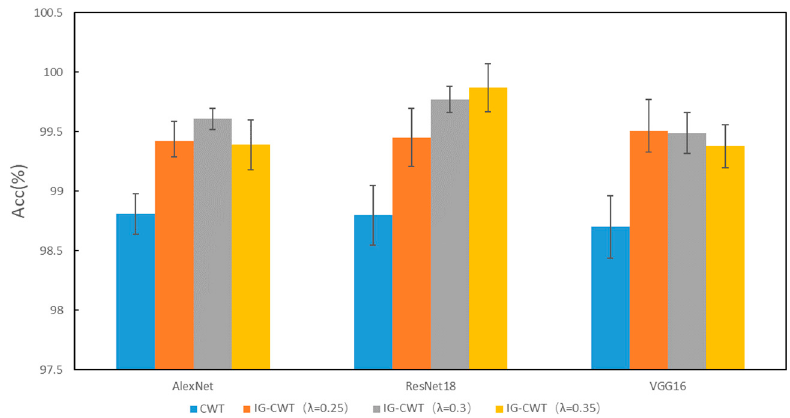
Figure 9. CWRU accuracy of IG-CWT and CWT. Table 4. Results of different λ on CWRU.